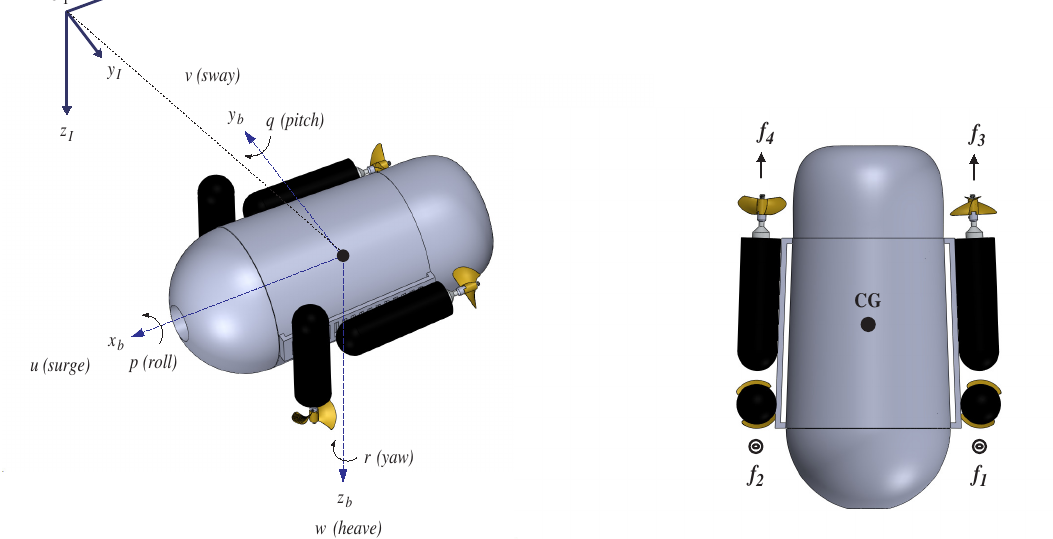
Figure 3. The AR2D2 µ AUV, with the body fixed frame ( O b , x b , y b , z b ) , the earth-fixed frame ( O ) , and the forces generated by its four I , x I , y I , z I